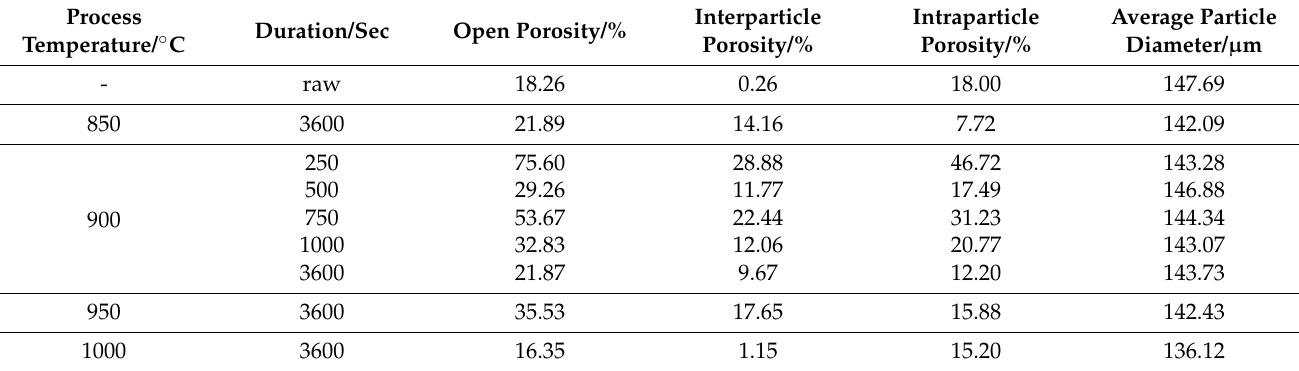
Table 7. Change in the open porosity of calcium sorbents during the calcination process with simultaneous sulfation.